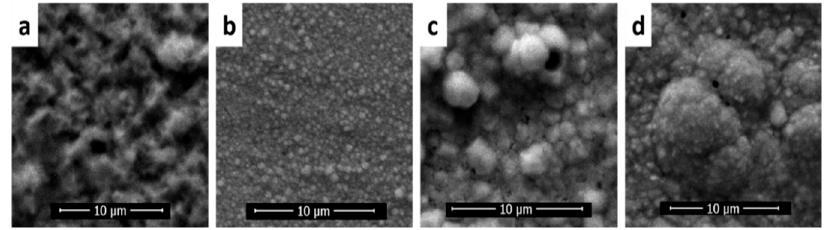
Figure 4. SEM images of copper coatings at ( a ) 0.7, ( b ) 1, ( c ) 1.5 and ( d ) 2